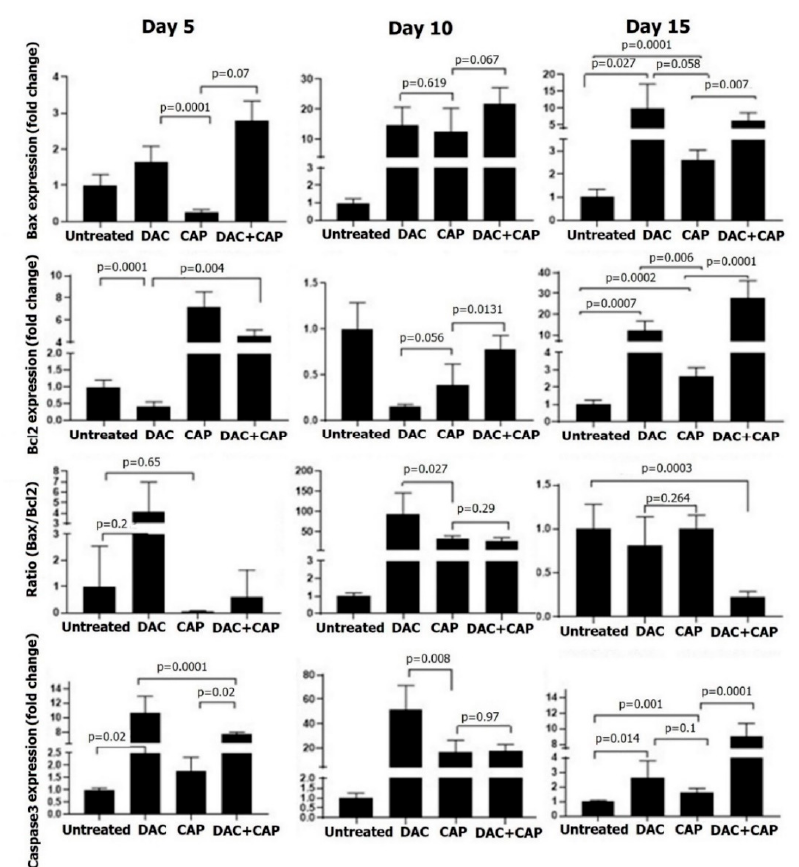
Figure 7. Apoptotic gene expression in melanoma samples subjected to CAP or DAC mono or combination therapy. Shown are results for Bax, Bcl2, and caspase 3 in tumor tissue lysates collected at days 5, 10, and 15. Real-time PCR was performed using GAPDH as a housekeeping control gene. Altered gene expression is shown as fold changes referring to untreated control cells. The results are representative of three mice per time point. Statistical analysis was performed using one-way ANOVA with Tukey’s post hoc test to untreated normalized